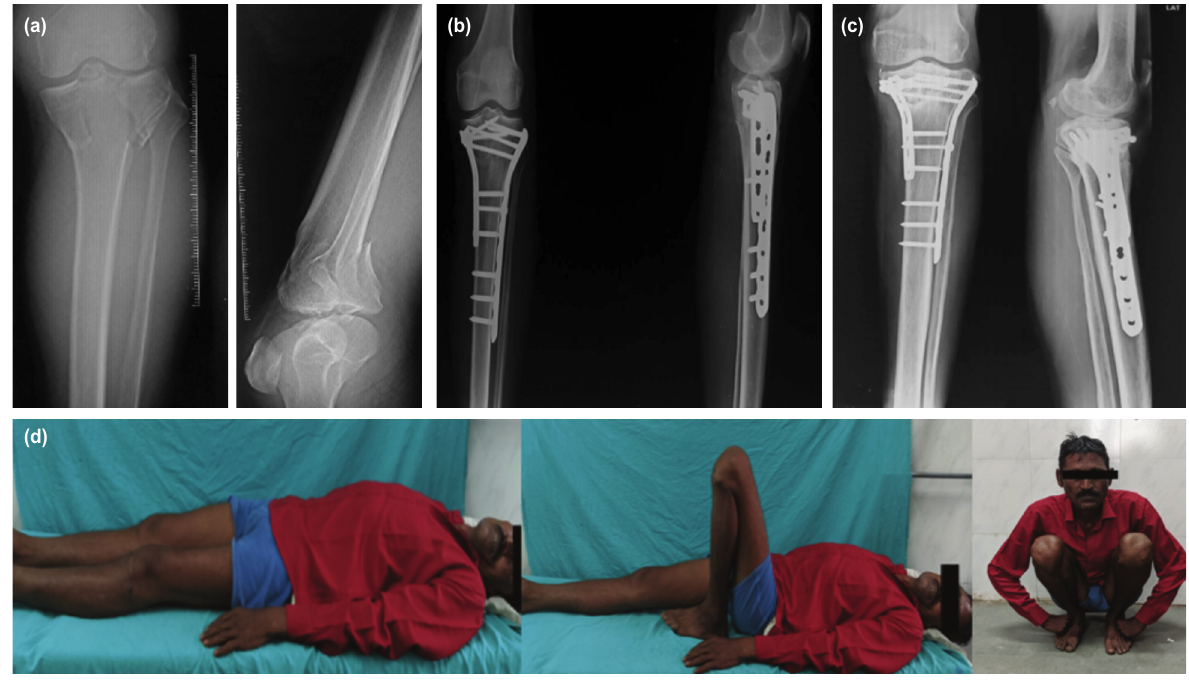
(a) Radiograph showing bicondylar tibial plateau fracture. (b) Post-operative radiograph showing fixation with dual plating. (c) Fig. 2: Six months post-operative radiograph showing union. (d) Clinical pictures showing good range of